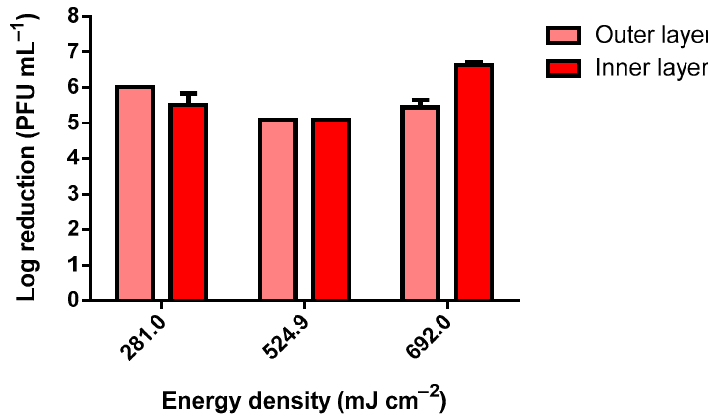
Figure 4. MS2 bacteriophage log reduction using a 75 W UV-C lamp (inoculum titer: approximately 1 × 10 12 PFU mL − 1 ).